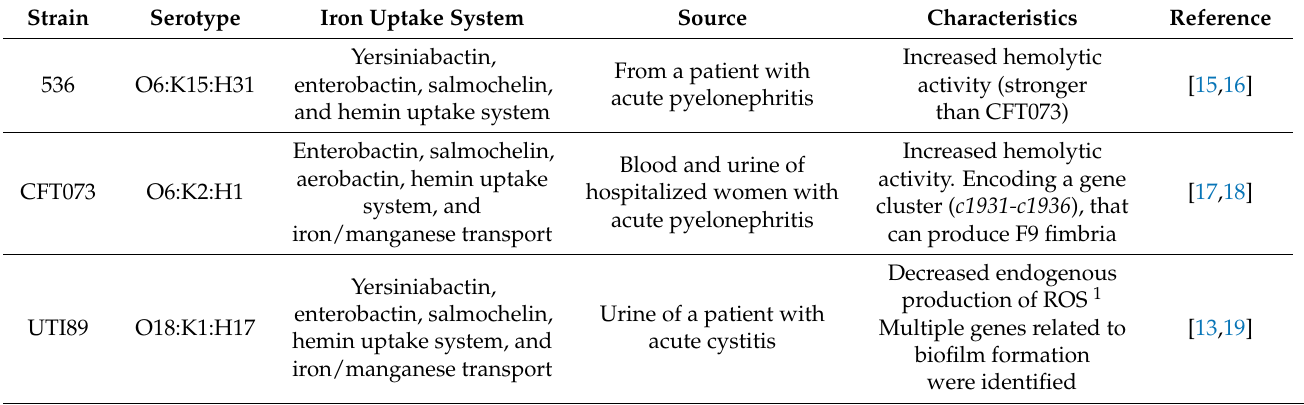
Table 1. Common strains of UPEC used in UTI studies with different